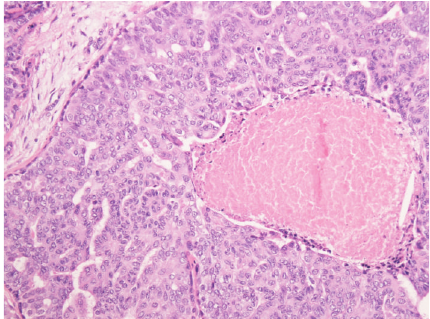
Figure 2: Area of necrosis, × 200.